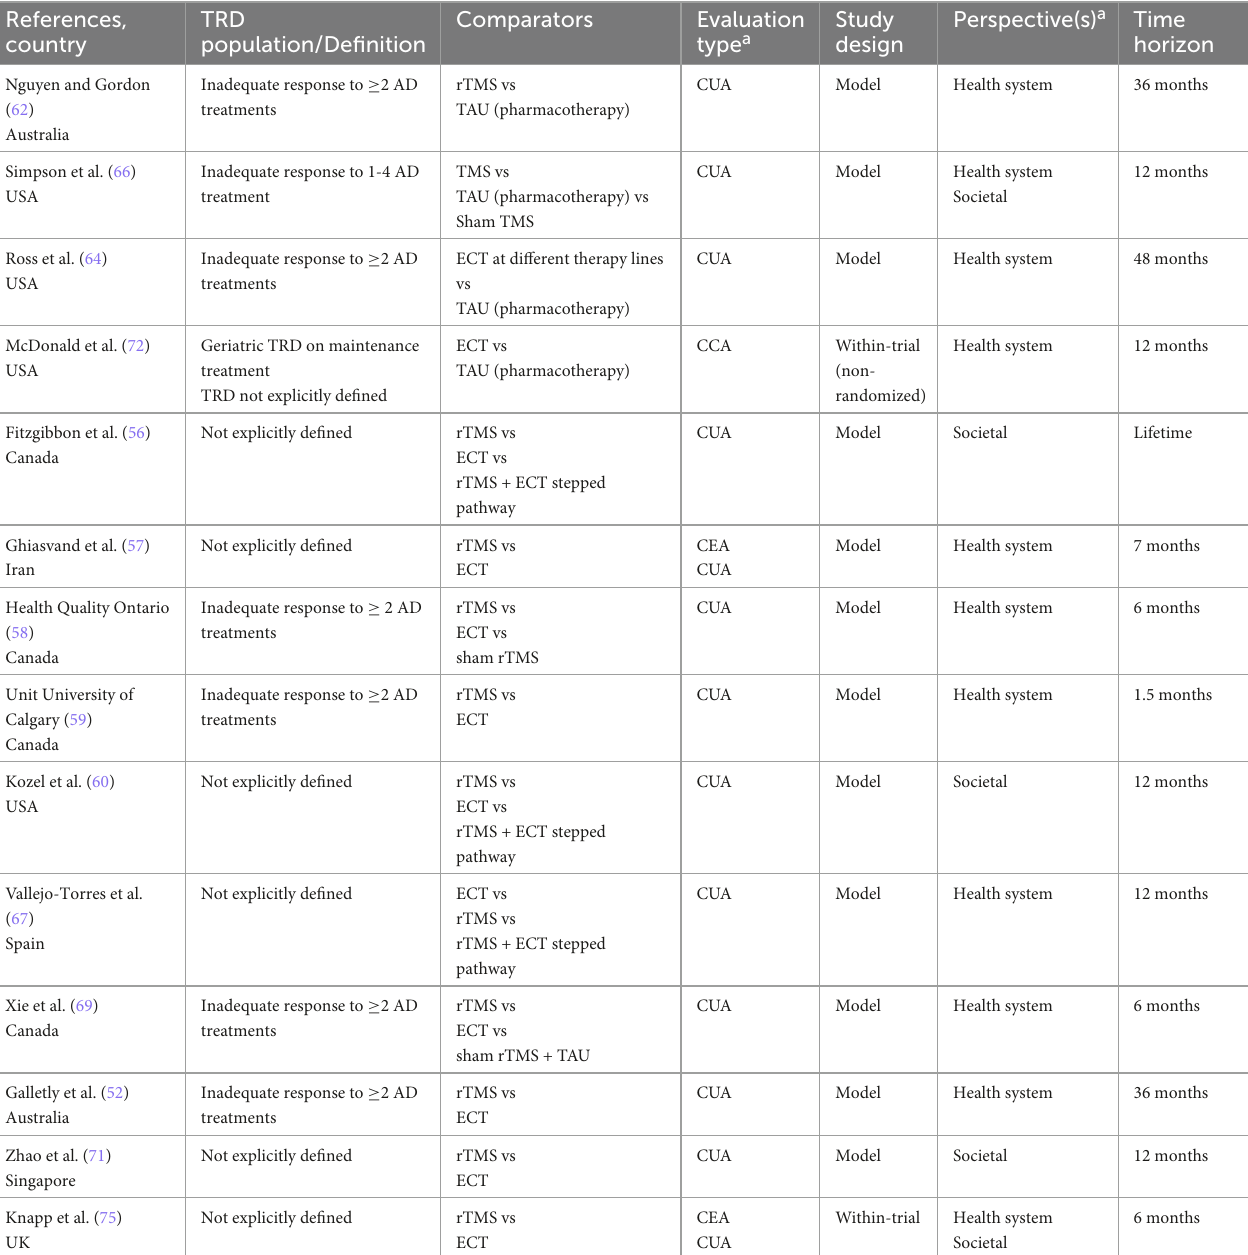
TABLE 2A Characteristics of economic evaluations of non-pharmacological neuromodulation